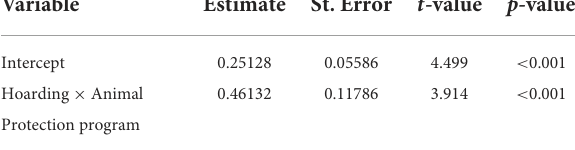
TABLE 4 Results of the generalized linear model between the hoarding perception index and the animal protection program perception index out of 29 cities belonging to the metropolitan area of Curitiba, Parana State,